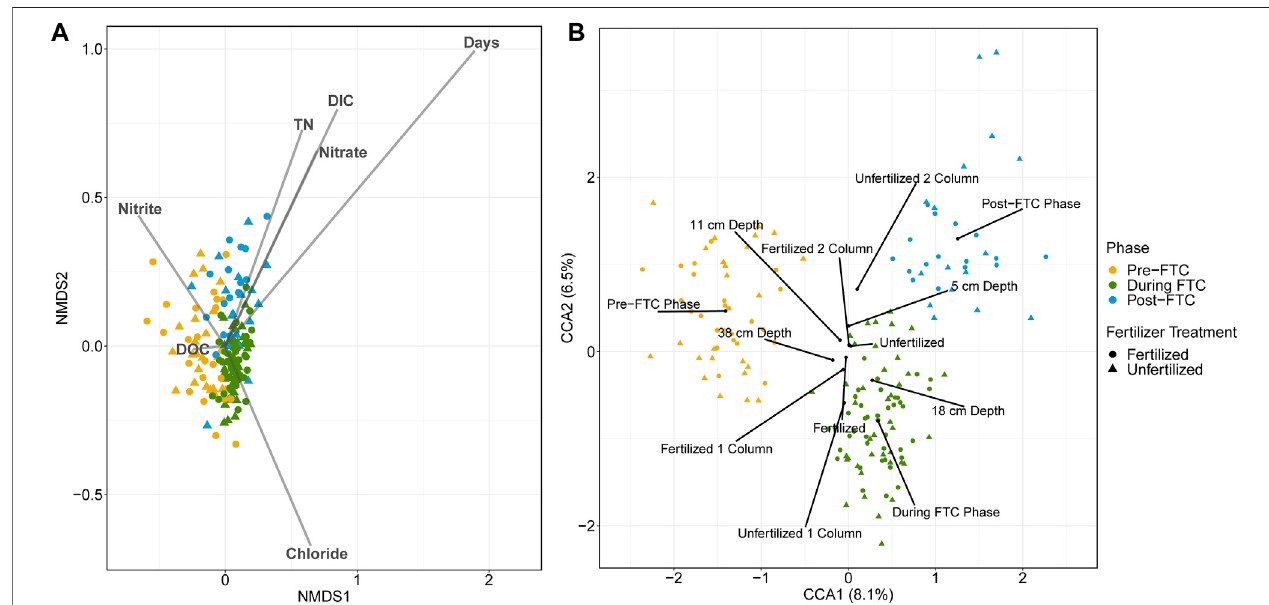
FIGURE 4 | Bacterial and archaeal canonical ordination. Ordinations are generated from Bray-Curtis distances of all 7390 ASV relative abundances across all 160 soil samples. Samples are indicated by colour for the phase of freeze-thaw cycling (green for pre-FTC; blue for during FTC; red for post-FTC), and shape for fertilizer treatment(circleforfertilized;triangleforunfertilized).AnnMDSplot (A) withvectorsrepresentingtimeaswellasgeochemicalvariablesobtainedfromthesoilleachateare overlayed. Timeis the largest continuous variable contributor to sample dissimilarity with the largest vector and the samples clearly segregated by phase of freeze- thaw cycling. ACCA plot (B) withcentroids representing thefactor levels ofcategorical variables including phase, depth, column, and fertilizer are shown. Thestrongest categorical variable for in fl uencing sample dissimilatory is phase, indicated by segregated samples by phase. Despite this the two principal coordinate axes explain only 6.5 and 8.1% of the variation in the